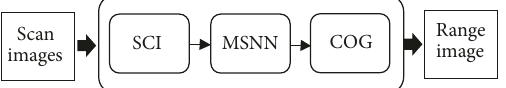
Figure 17: Data flow graph for Experiment 2.